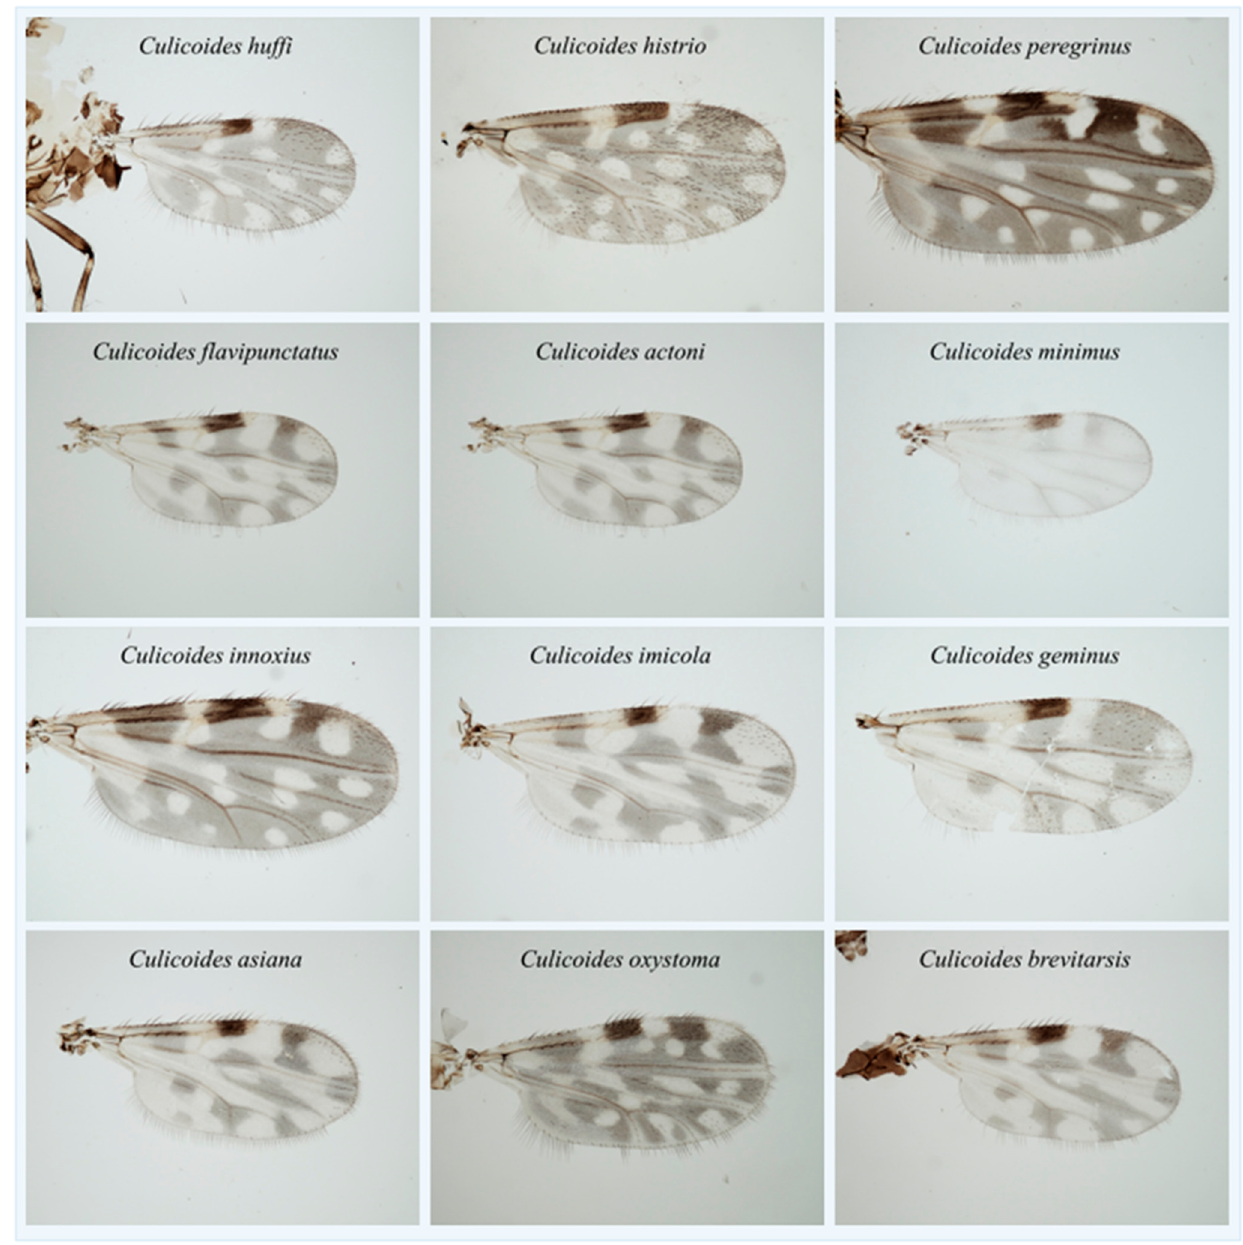
Figure 3. Wings of the 12 female Culicoides species collected in horse farms in Hua Hin district, Prachuab, Khiri Khan province, Thailand.